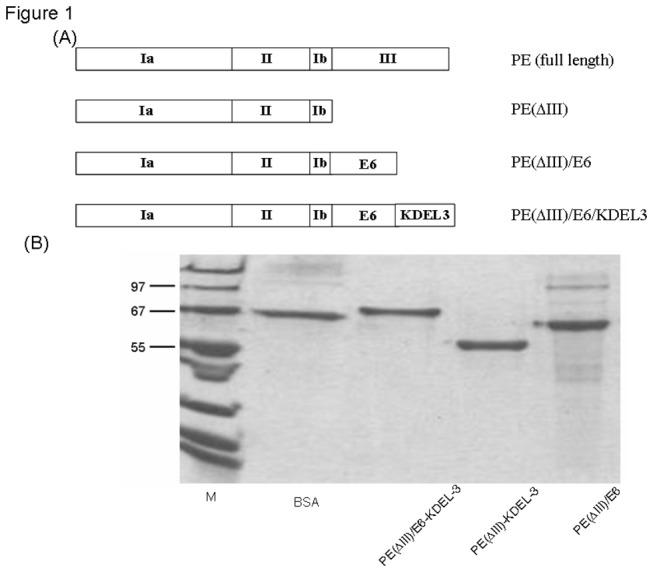
Chimeric PE(ΔIII)/E6 DNA construct and characterization of PE(ΔIII)/E6 fusion protein expression.(A) The schematic diagram of the constructs for the full-length exotoxin and PE(ΔIII), PE(ΔIII)-KDEL-3, and PE(ΔIII)-E6-KDEL-3 genes. (B) The SDS-PAGE pattern of various E6 fusion proteins. Lane 1, BSA standard; Lane 2, PE(ΔIII)-E6-K3; Lane 3 PE(ΔIII)-K3,; Lane 4, PE(ΔIII)-E6.